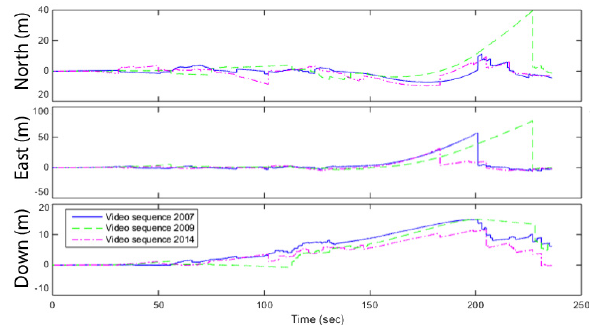
Figure 14: Position error between true vehicle position and the position calculated from IMU data integrated with VNS in North, East and down directions.